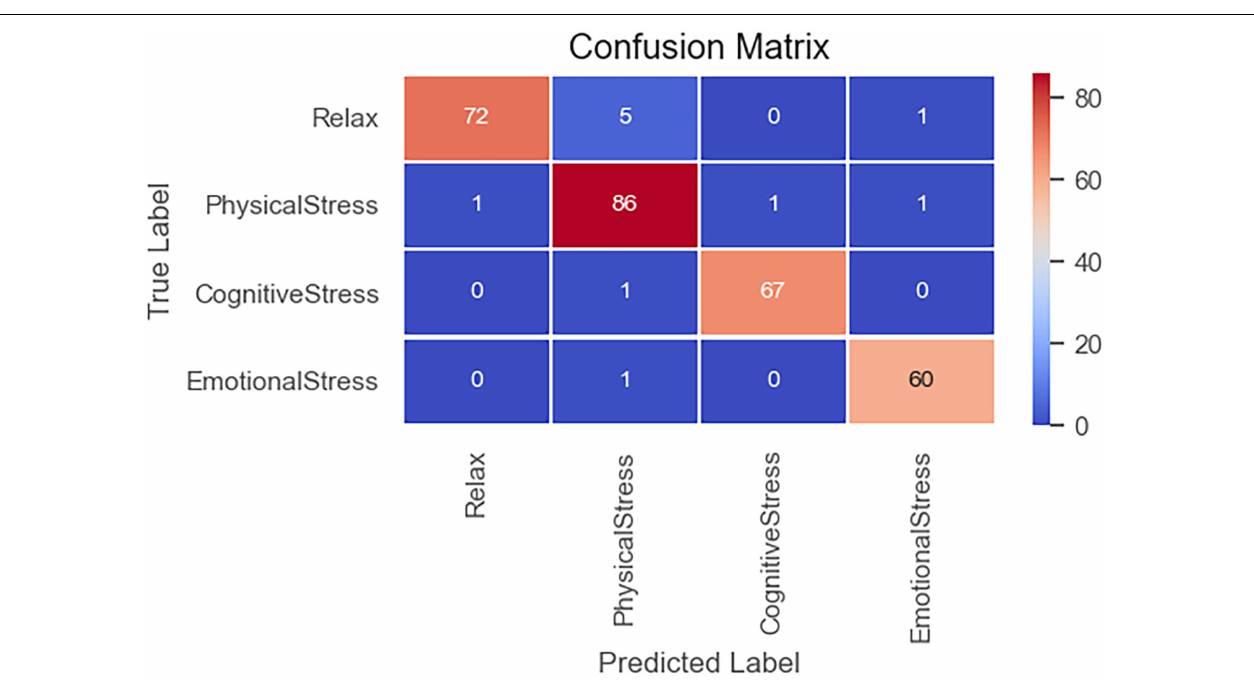
FIGURE 11 | Confusion matrix of test